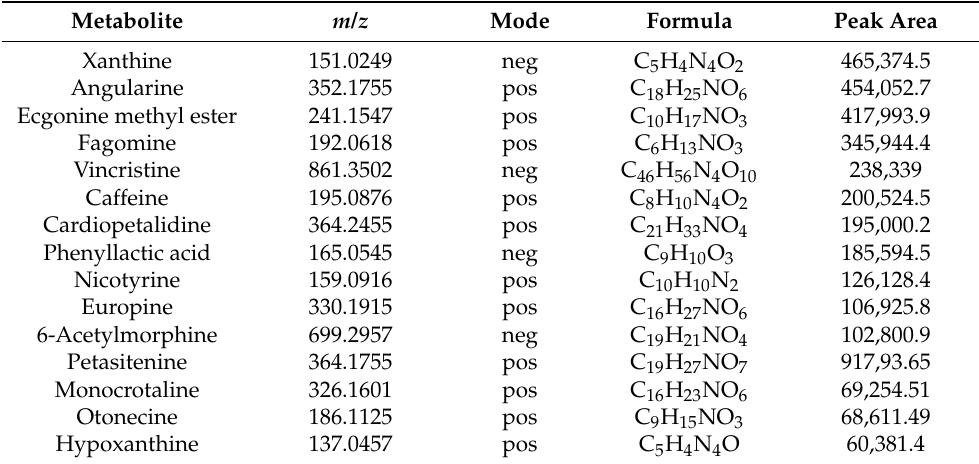
Table 1. Alkaloids in J-15-Ms.